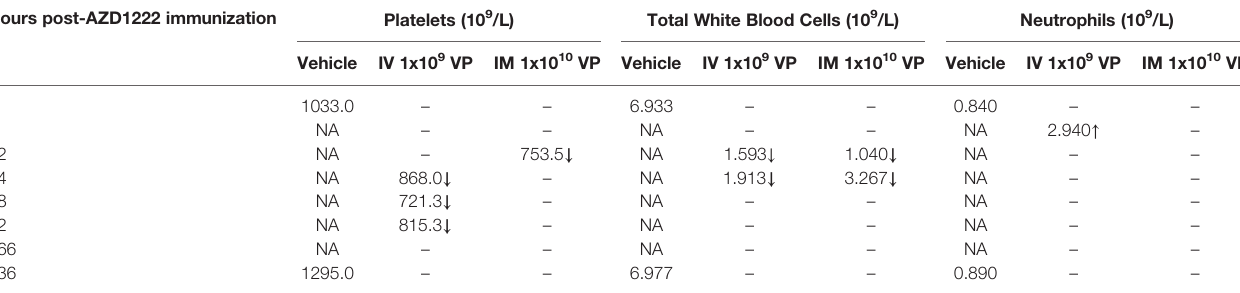
TABLE 2 | Effects on host immune response and hematology parameters immediately following AZD1222